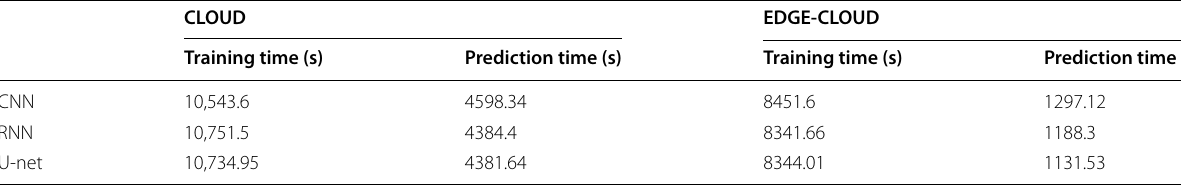
Table 9 Experimental results for model training and prediction using cloud and edge-cloud setup